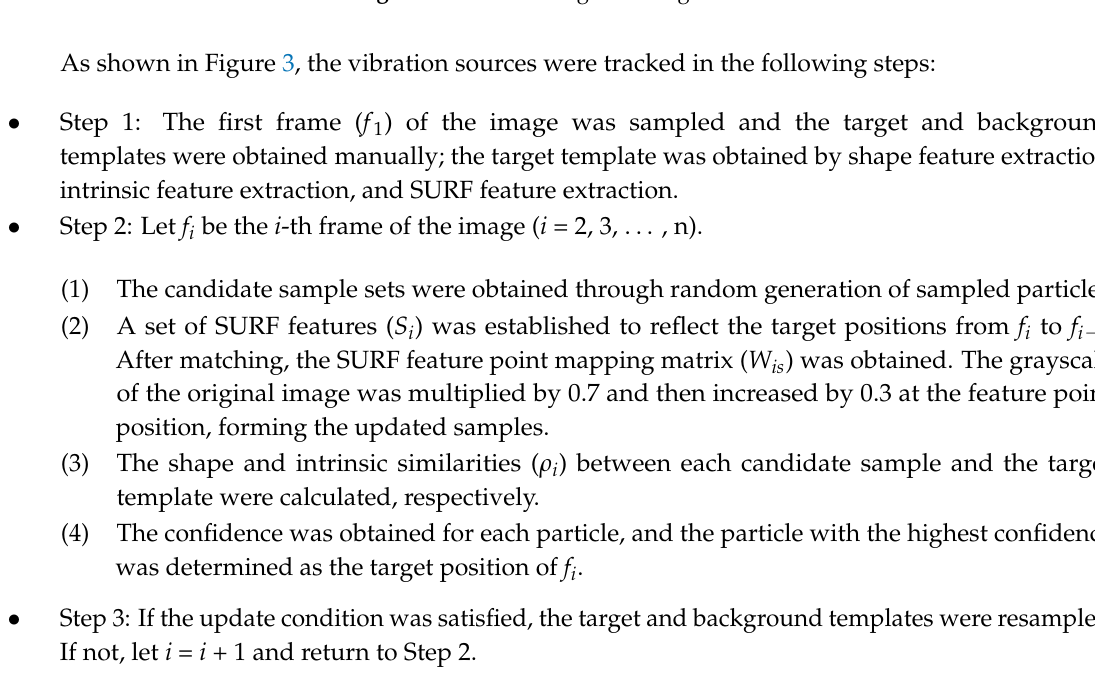
Figure 3. The flow diagram of algorithm.